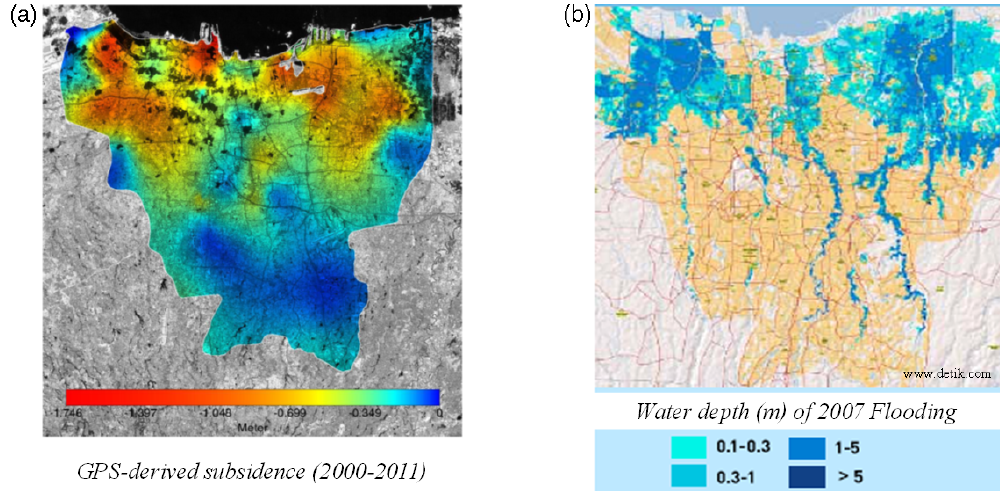
Figure 6. Spatial correlation between GPS-derived land subsidence (2000–2011) and flooding area in Jakarta